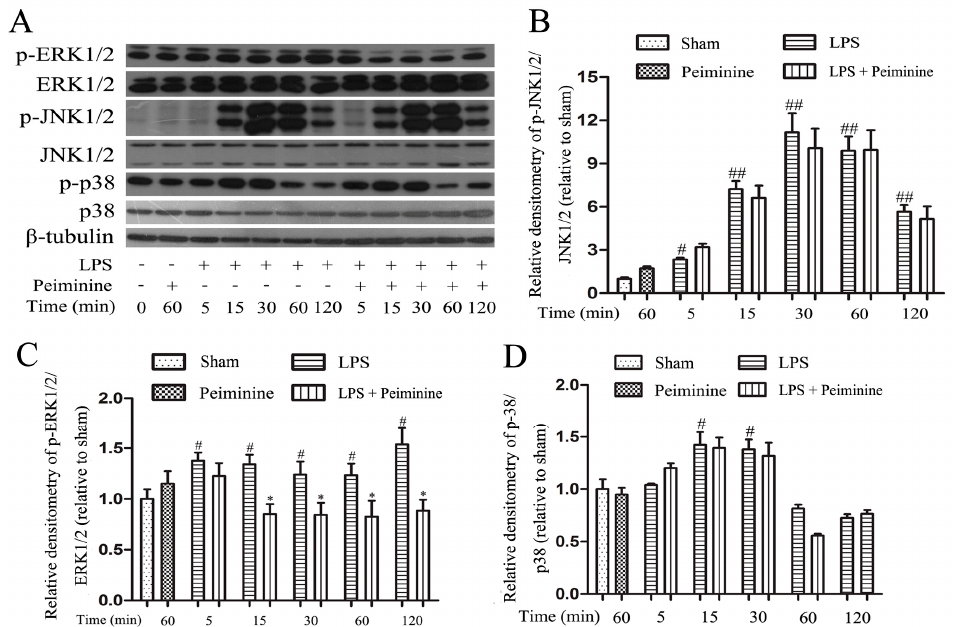
Figure 7. Peiminine suppresses LPS-induced ERK1/2 phosphorylation in BV-2 cells. Cells were pretreated with peiminine (50 μ g/mL) for 1 h and then stimulated with LPS (1 μ g/mL) for 5, 15, 30, 60 or 120 min. Western blot results ( A ) ( n = 3). Peiminine inhibited LPS-induced ERK1/2 phosphorylation ( C ), but failed to inhibit the phosphorylation of JNK1/2 and p38 ( B , D ). # p < 0.05 and ## p < 0.01 compared to the sham group, * p < 0.05 compared to the LPS group at the same time point.